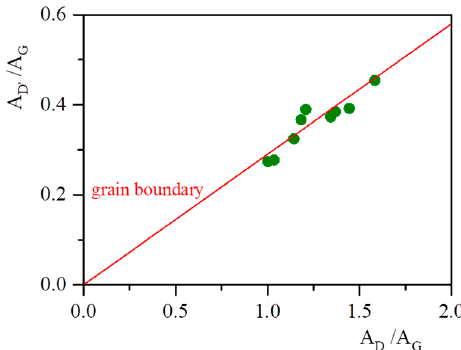
Figure 1. Variation of the relative intensity of the D ′ band with the relative intensity of the D band for different graphene oxides obtained from GANF ® carbon nanofibers followed by thermal annealing. The relative intensities are expressed in terms of area under bands. The line was calculated according to theoretical model for grain boundary defects.